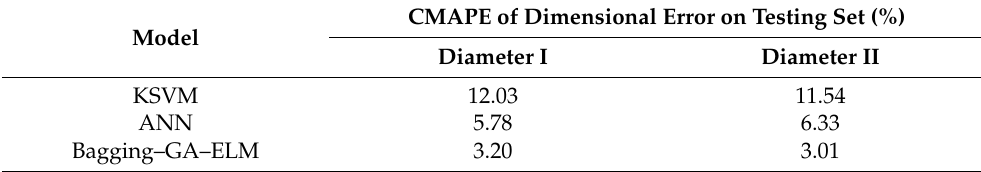
Table 6. The comparison among different prediction